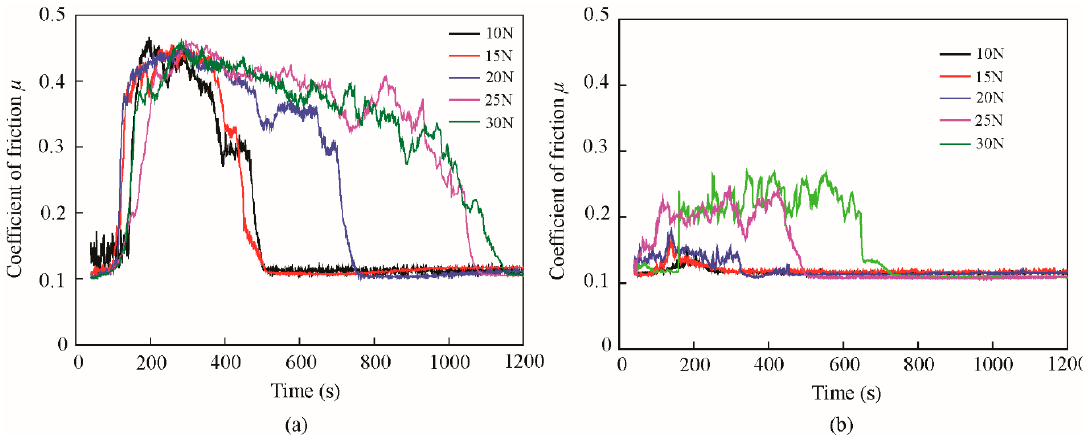
Figure 14. Typical friction coefficient of ( a ) the base oil and ( b ) that with 1.0 wt% ZrS 2 nanobelt additives with different normal loads.